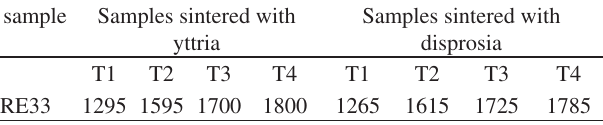
Table 4. Temperatures (°C) of maximum or minumum shrinkage rate for samples sintered in dilatometer at 1950 °C/1h (see text for